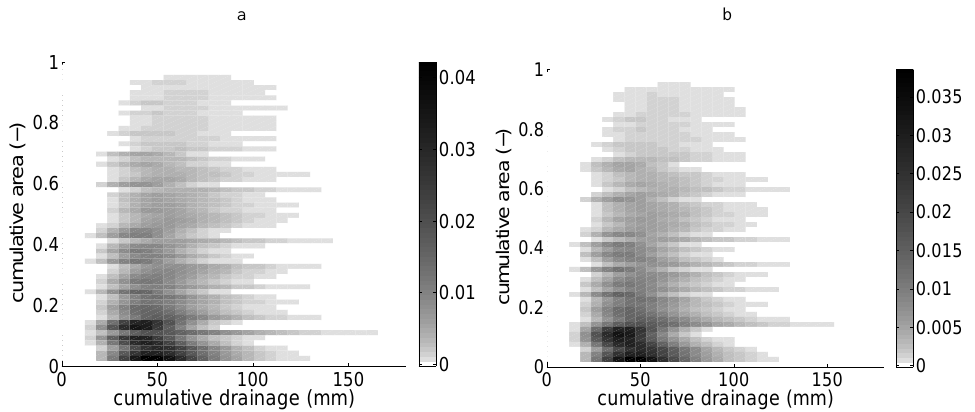
Fig. 12. Scaled solute flux density (d − 1 ) from simulations, at 0.5 m depth, for a steady state atmospheric flux of 25 mm d − 1 . (a) . Tracer (b) . Degradable solute (half-life time τ =10 d).